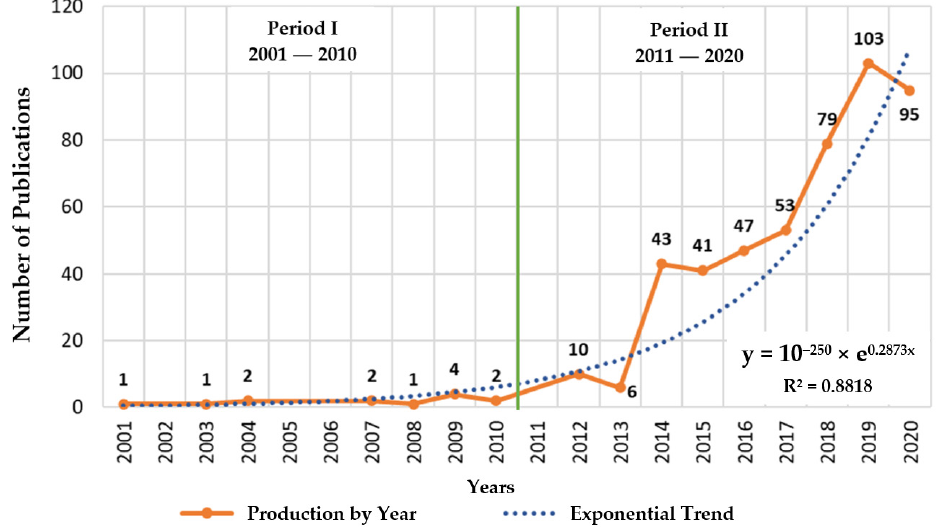
Figure 5. Scientific production in the period (2001–2020).